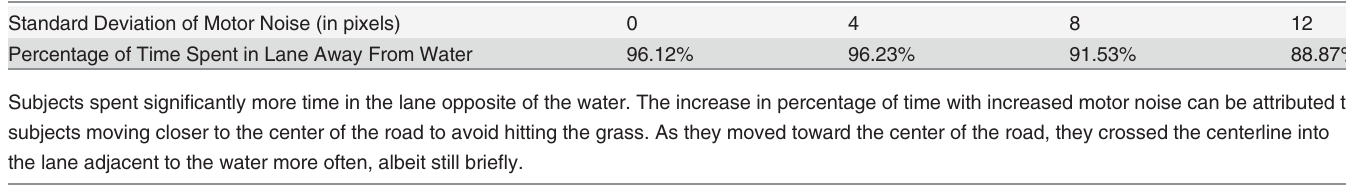
[R 2 (symmetrical low-cost task) = 0.982, R 2 (symmetrical high-cost task) = 0.984, R 2 (asym- metrical task) = 0.945]. A two-way ANOVA showed that there was a significant effect of motor noise [F(4,408) = 92.64, p < 0.001], task type [F(2,408) = 112.61, p < 0.001], and interaction [F (6,408) = 4.157, p < 0.001] on the distance of the bimodal Gaussian position distribution peaks from the center of the road. In post hoc pairwise comparisons between task types within each uncertainty level, all were significant (p < 0.05) except between the symmetric low-cost task and asymmetric task at 0 and 4 psd noise. Details can be found in Fig 6. Subjects, on average, ran off the road in more than twice as many trials at every level of un- certainty in the asymmetric task than in the low-cost task, shown in Fig 7. These numbers do not include failures during practice. However, at the two lowest levels of motor noise in the low-cost task, even during the initial practice block, no subject ran off the road. Additionally, only one subject ever fell off the road in the high-cost task. This demonstrates that subjects react to the probability of failure even when failure has not been experienced. This observation is inconsistent with an adaptive reduction in error, and instead must represent a mechanism that estimates and predicts failure that has not yet occurred.